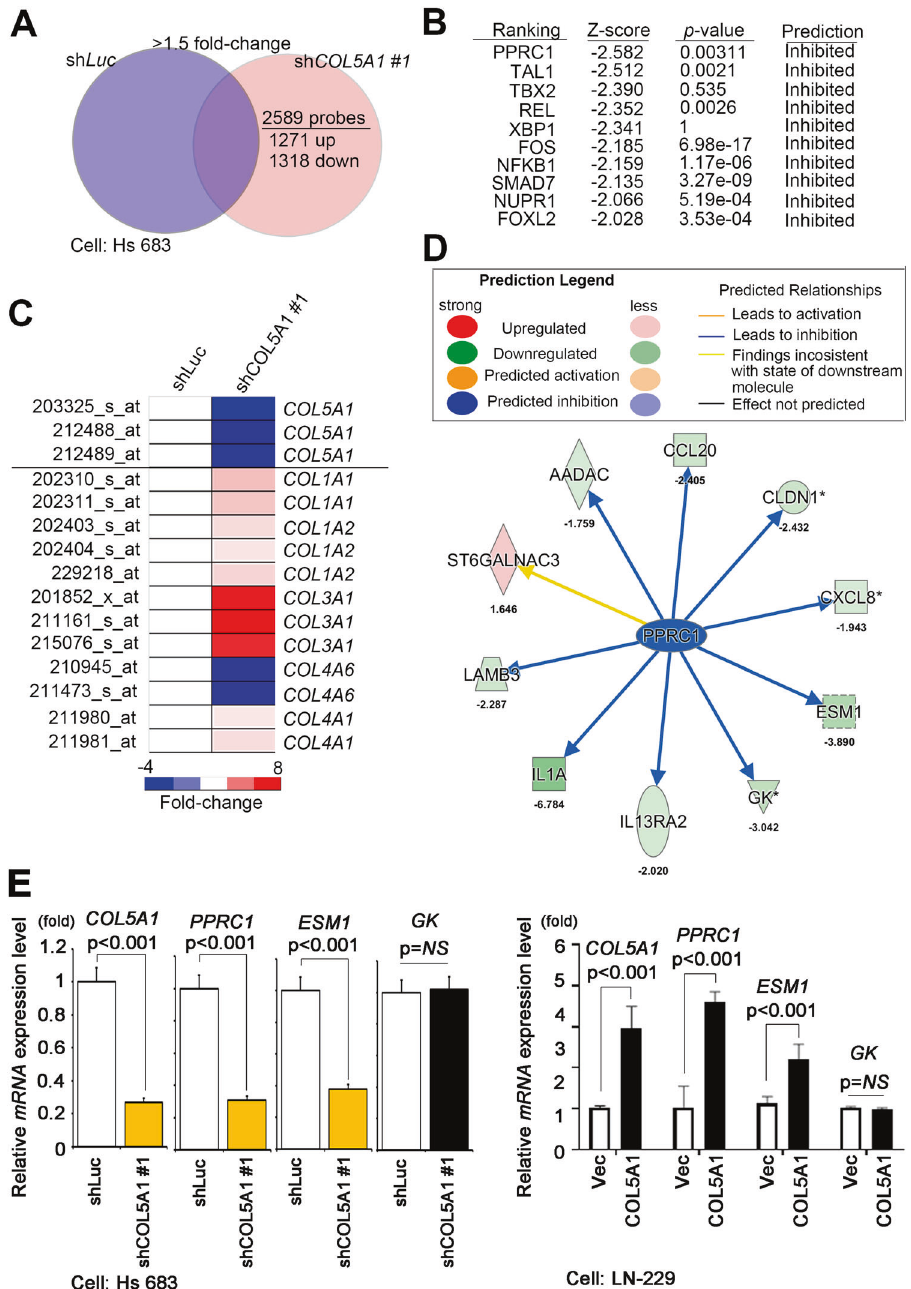
Fig. 5 COL5A1 modulates the activity of PPRC1 and its downstream target ESM1. A Venn diagram illustrating that when comparing Hs 683 shCOL5A1 #1 and Hs 683 shLuc cells, 2589 probes with a cutoff value >1.5-fold change were identi fi ed. B Ranking of the upstream transcriptional regulators of predicted candidate genes according to the IPA database of the Hs 683 shCOL5A1 microarray compared to the Hs 683 shLuc microarray. C The heatmap shows the expression levels of collagen family members in the available chips. D The network was predicted using the selection signature that was overlaid with microarray data from Hs 683 shCOL5A1 cells with a 1.5-fold change cutoff in the IPA database. The intensity of the node color indicates the degree of activating (orange) or inhibiting (blue) regulation following COL5A1 interactions. E The downstream targets of PPRC1 were analyzed by qRT-PCR in the Hs 683 COL5A1-knockdown model and the LN-229 COL5A1-overexpression model. The signi fi cance of the difference was analyzed using the nonparametric Mann – Whitney U test.